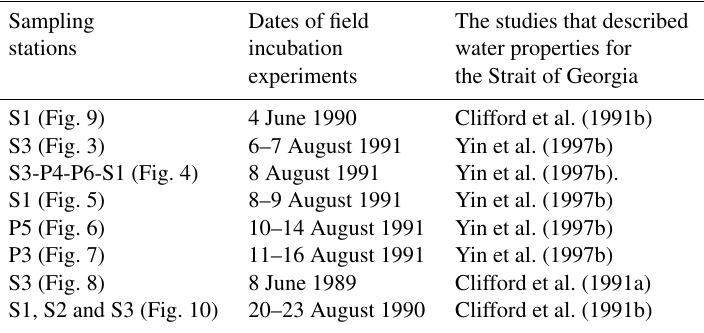
Table 1. Water column conditions, such as vertical profiles of salinity, temperature and fluorescence, that can be found in the listed publica- tions for the sampled stations in the Strait of Georgia.